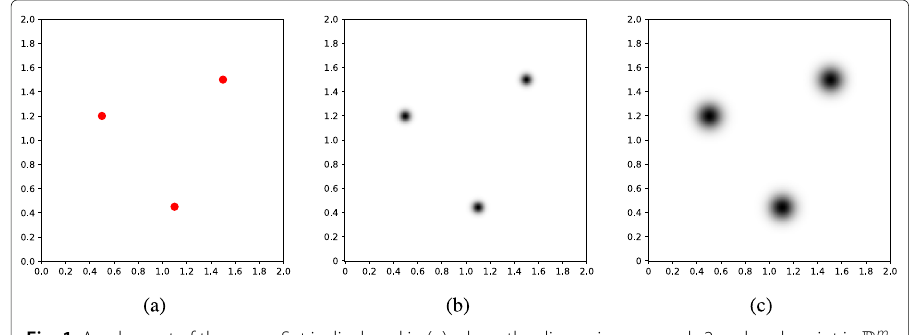
Fig. 1 An element of the space Set is displayed in ( a ) where the dimension m equals 2 and each point in R m is represented by a red dot. The elements of R R m , which are themselves functions R m → R , resulting from applying the map F to this element with σ parameter values of 0.001 and 0.0005 are displayed in ( b ) and ( c )